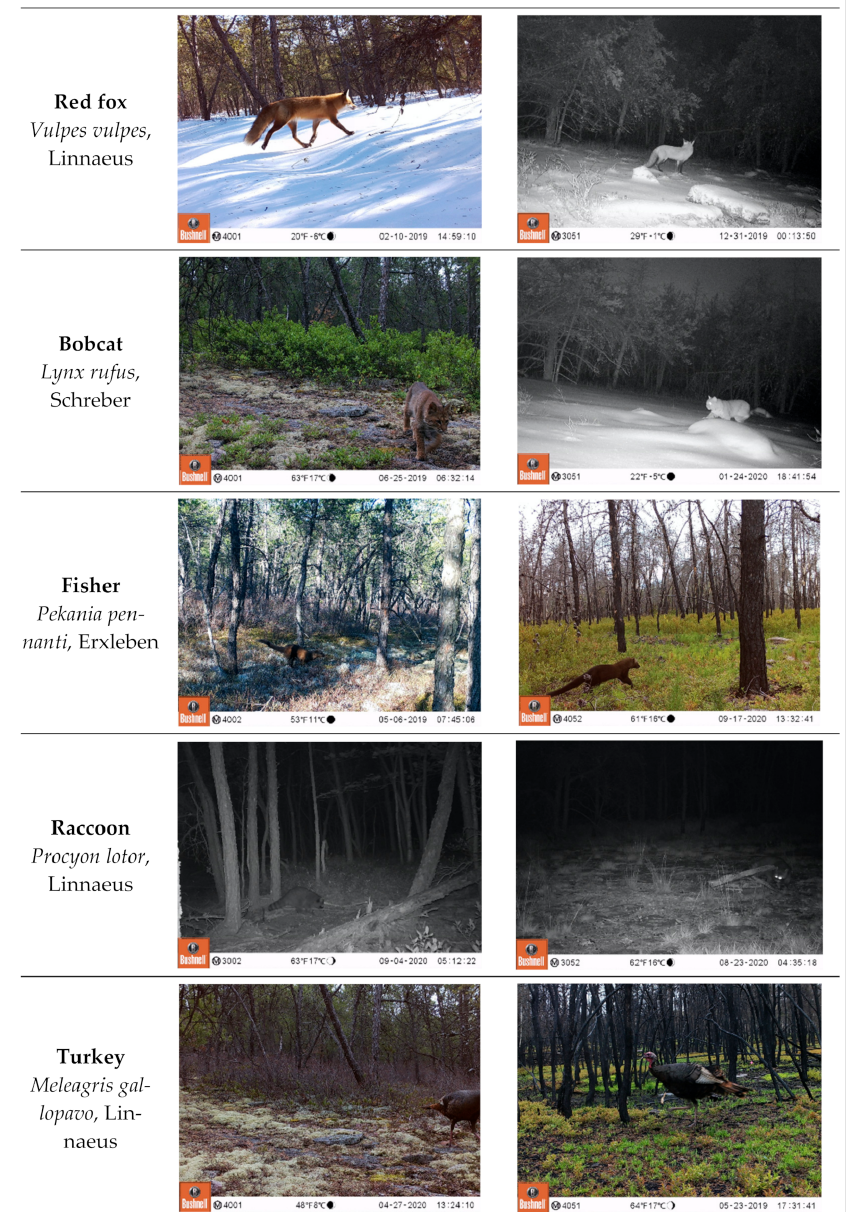
Figure A1. Representative game camera photos from the reference and disturbed